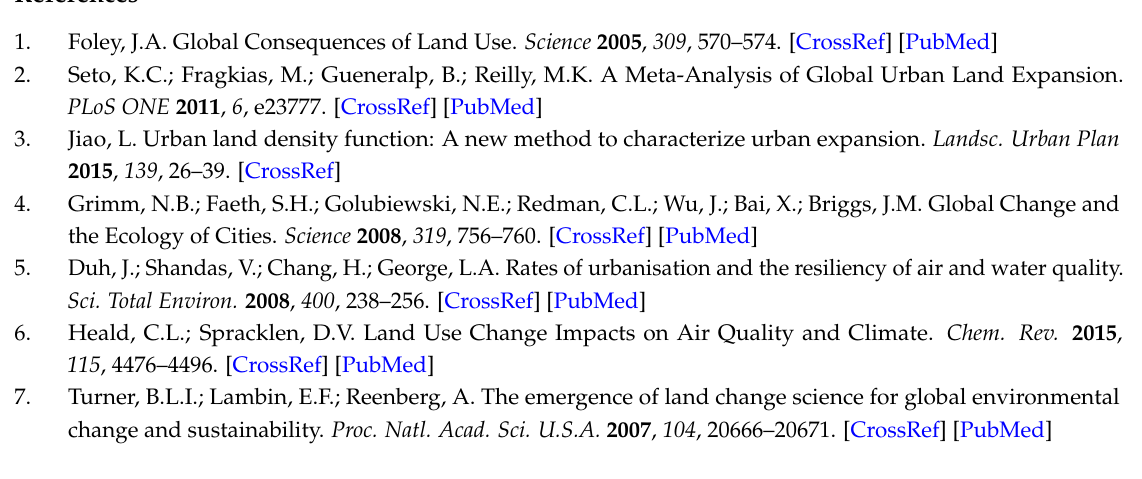
Figure S1: Frequency distribution histograms of air pollutants and land use variables, Figure S2: Spatial distribution of eight-year (2007–2014) average concentrations of three air pollutants in Wuhan based on IDW interpolation in ArcGIS10.1 with default parameters: (a) SO 2 concentration; (b) NO 2 concentration; (c) PM 10 concentration, Table S1: Detailed description of nine ambient air quality monitoring sites in Wuhan, Table S2: Detailed information on satellite images used for land use information